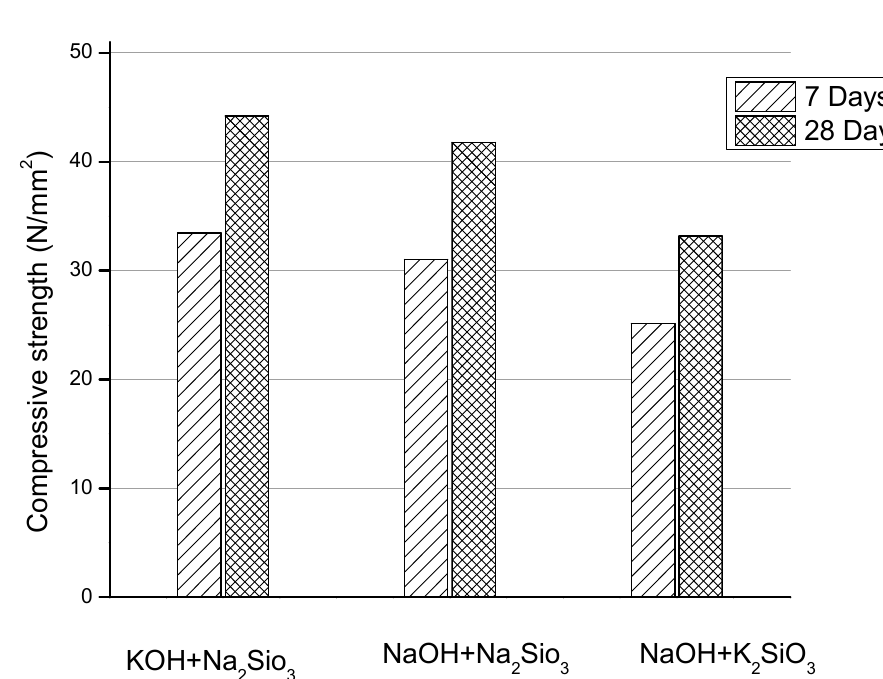
Figure 25. Comparison of compressive strength of di ff erent activator combinations for 10M at 90 ◦ C, modified from [163], Morse Florse,